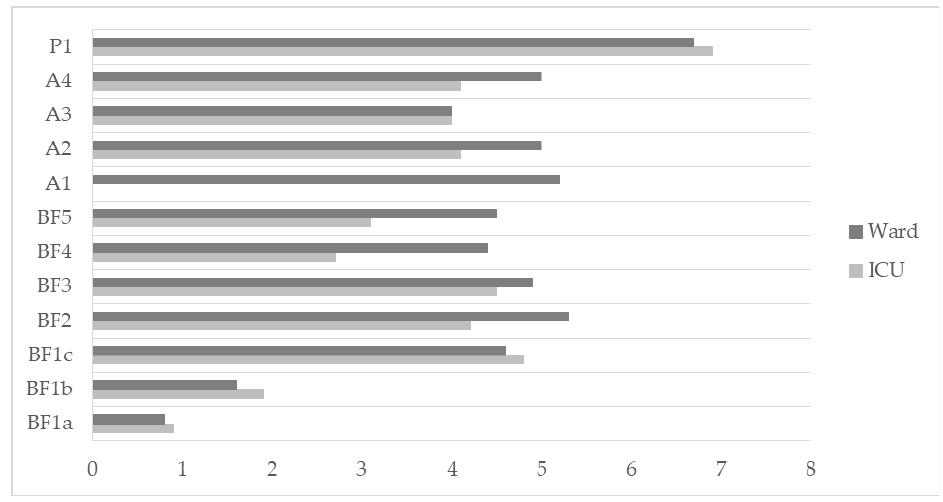
Figure 1. COVID-19 mean symptom intensity at 12 weeks in ICU- and Ward-admitted patients. Legend: BF1 = Breathlessness: (a) at rest, (b) dressing, (c) stairs; BF2 = Fatigue; BF3 = Pain/discomfort; BF4 = Anxiety; BF5 = Depression; A1 = Communication; A2 = Mobility; A3 = Personal Care; A4 = Usual Activities; P1 = Global Health. Table 4. Correlations between the C19-YRS items and outcome measures. Abbreviations: 6MWT = 6-Minutes Walking Test; 5 Time-STS = 5 Time-Sit-To-Stand; BAI = Beck Anxiety Inventory; PHQ-9 = Patient Health Questionnaire-9; MCS-12 = Mental Health Composite Scale—Short Form 12; MoCA = Montreal Cognitive Assessment.